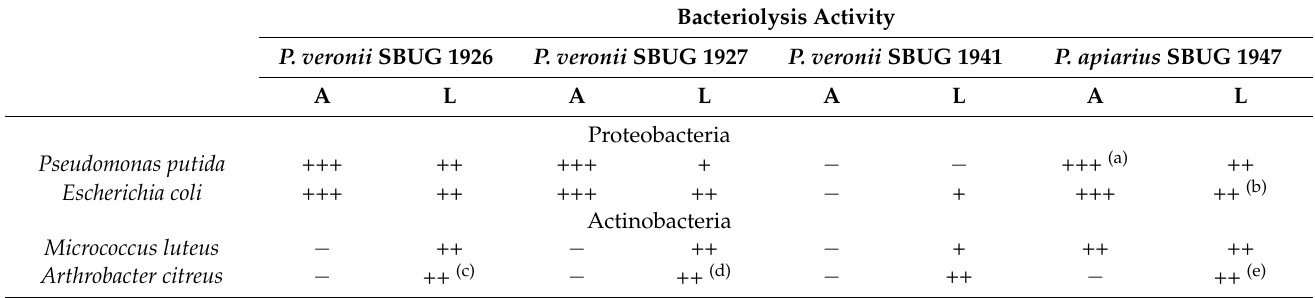
Table 3. Bacteriolysis activity of Pseudomonas veronii SBUG 1926, SBUG 1927, SBUG 1941 and Paenibacillus apiarius SBUG 1947 against autoclaved (A) and living (L) cells of the Gram-negative strains Pseudomonas putida and Escherichia coli as well as Gram-positive Micrococcus luteus and Arthrobacter citreus after five days of incubation at 30 ◦